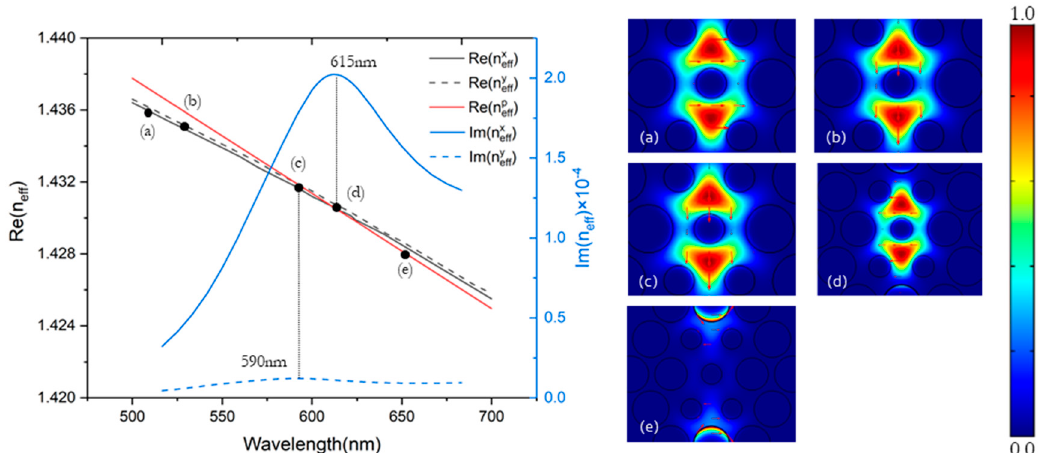
Figure 2. Dispersion relations and electric field distribution of core-guided modes and the plasmon mode with n a = 1.33. ( a ) x-polarized core mode at λ = 500 nm; ( b ) y-polarized core mode at λ = 500 nm; ( c ) y-polarized core mode at λ = 590 nm (phase matching point); ( d ) x-polarized core mode at λ = 615 nm (phase matching point); ( e ) Plasmon mode at λ = 650 nm.